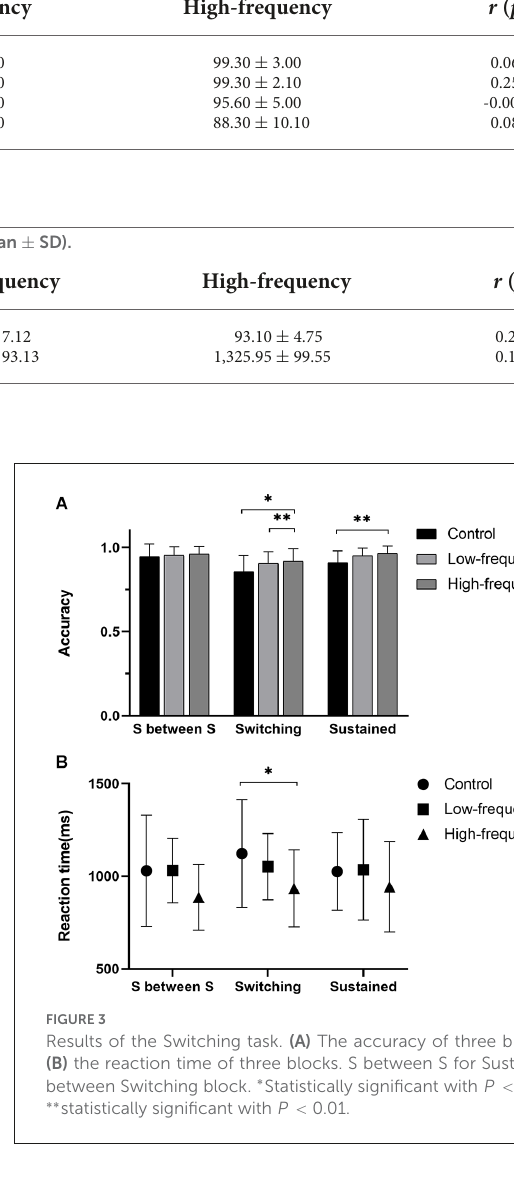
TABLE 2 The accuracy of the Stop Trials at different interval times in each group (Mean ± SD%). SOAs (ms)